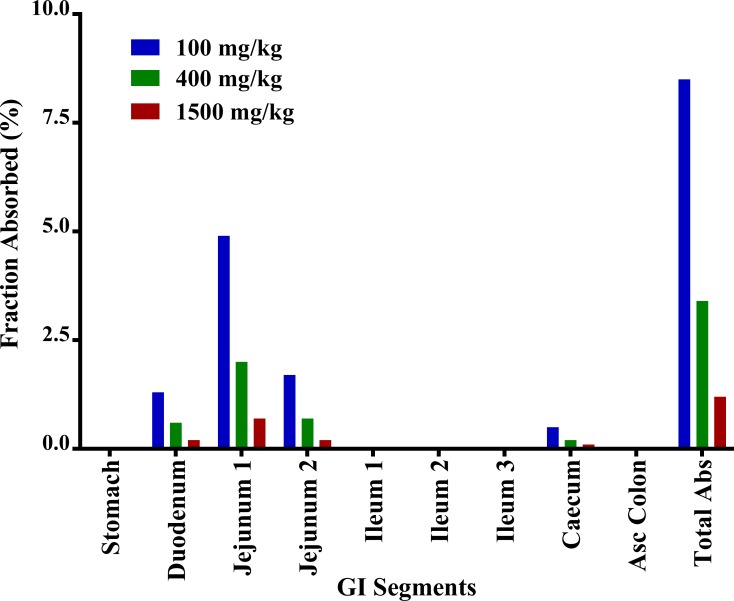
The fraction of regional absorption under fed condition in dogs after a single dose of SHetA2 suspension.